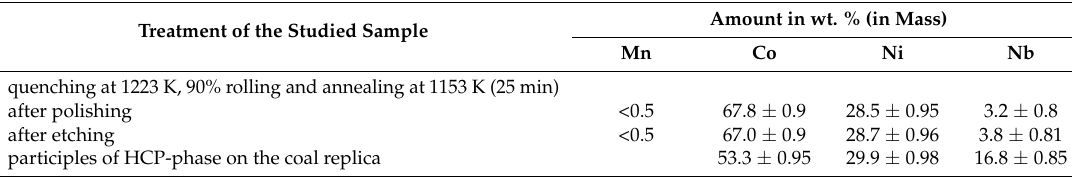
Table 1. Data of the chemical composition of the samples of the Co-Ni-Nb alloy obtained on an X-ray-fluorescent energy-dispersion spectrometer.